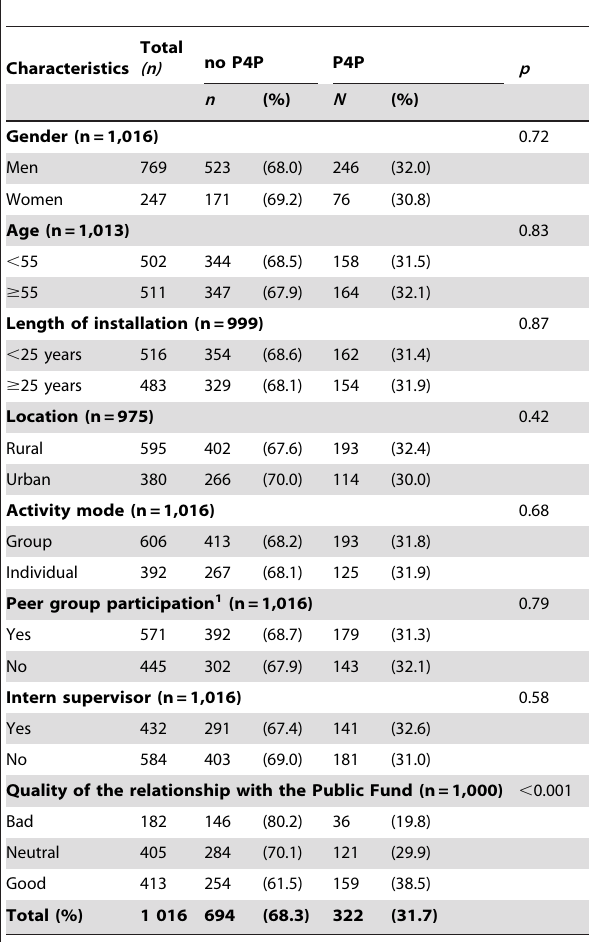
Table 2. Relationship between the CAPI subsciption and GP perception of ethical